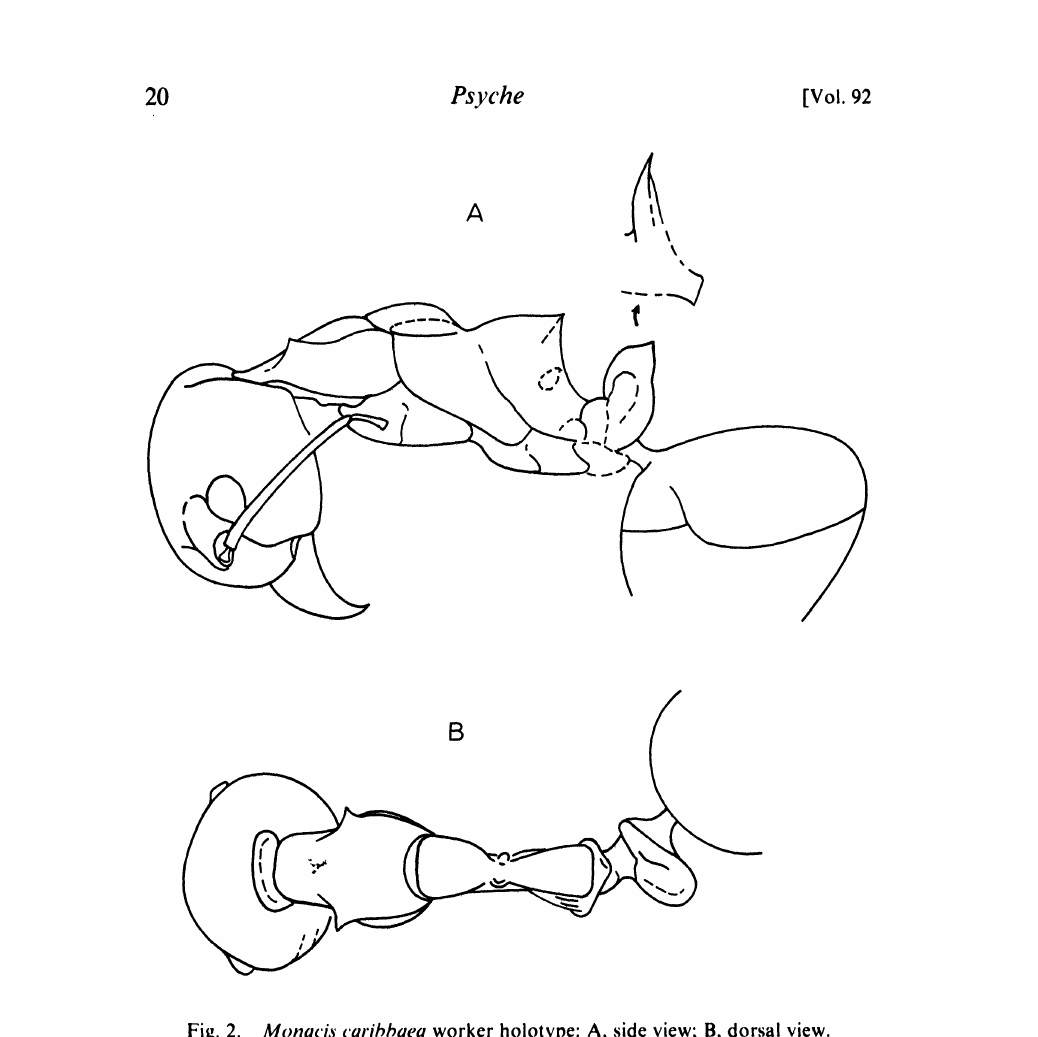
Fig. 2. Monacis carihhaea worker holotype: A, side view; B, dorsal